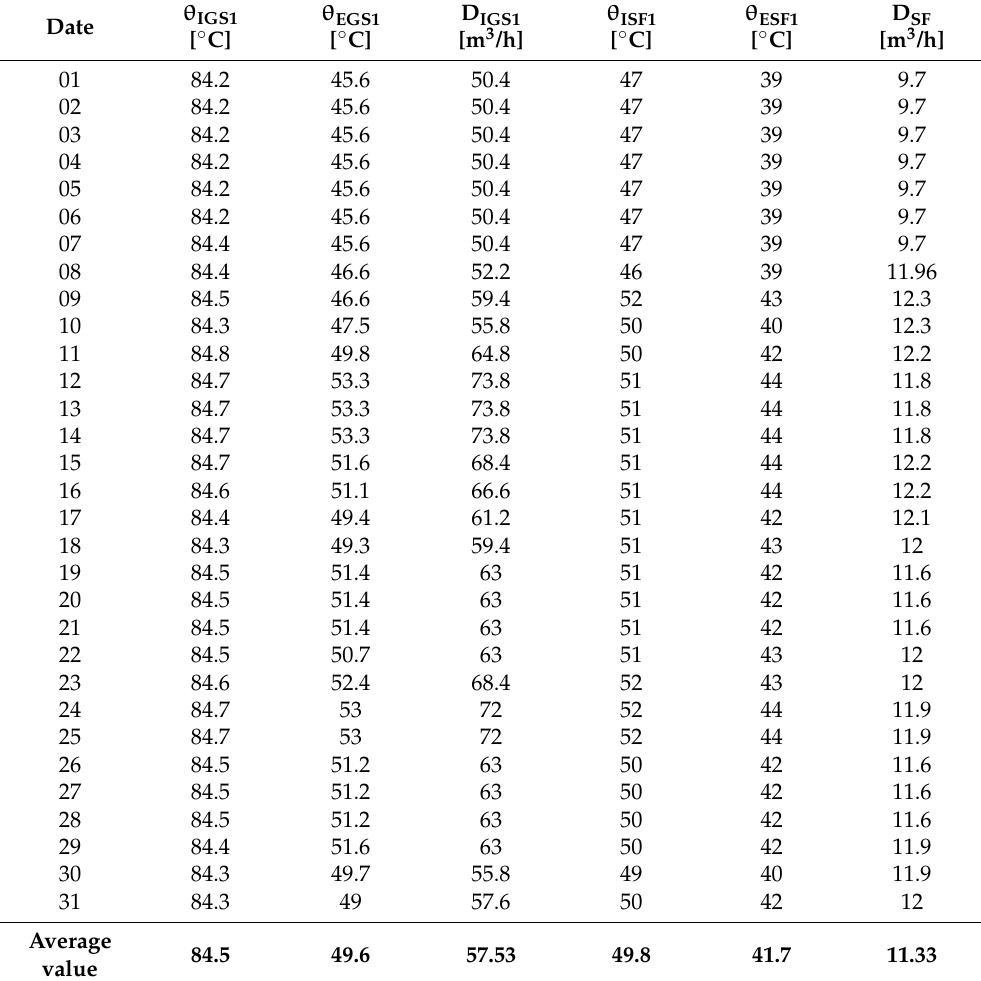
Table 3. Temperatures and flowrates of the GTW, SF (space heating and DHW) in TS1 (January